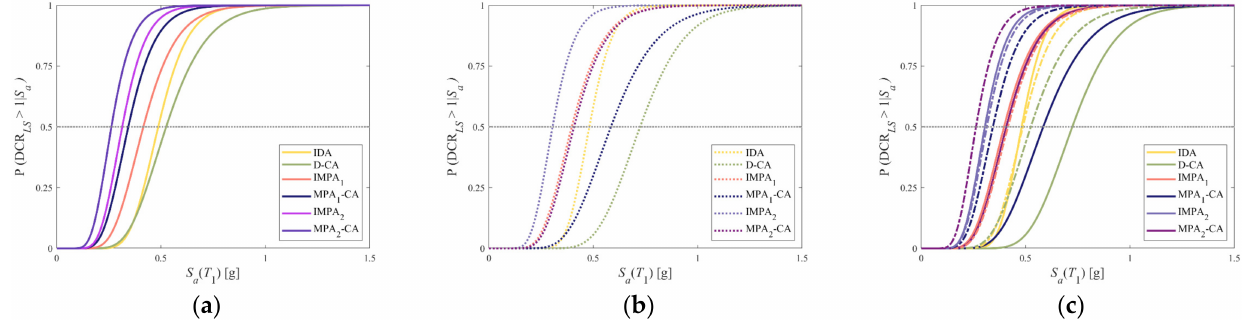
Figure 14. Comparison among fragility curves for all aforementioned methods: ( a ) comparison among fragility curves for near-fault (NF) selection ( b ) far-field (FF) selection, and ( c )